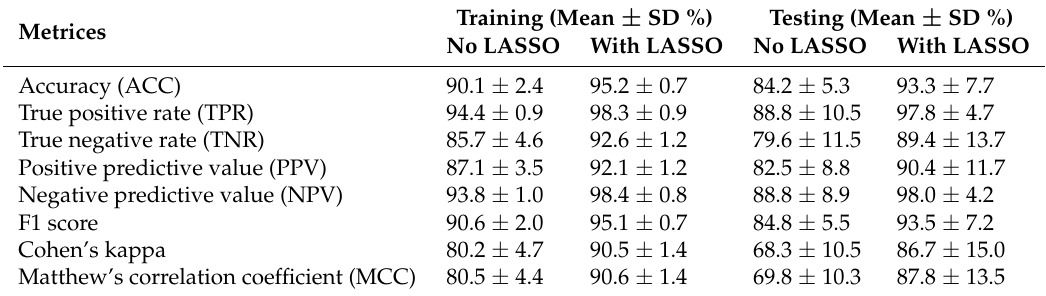
Table 6. Phase 2: Supervised machine learning result—SVM with linear kernel.